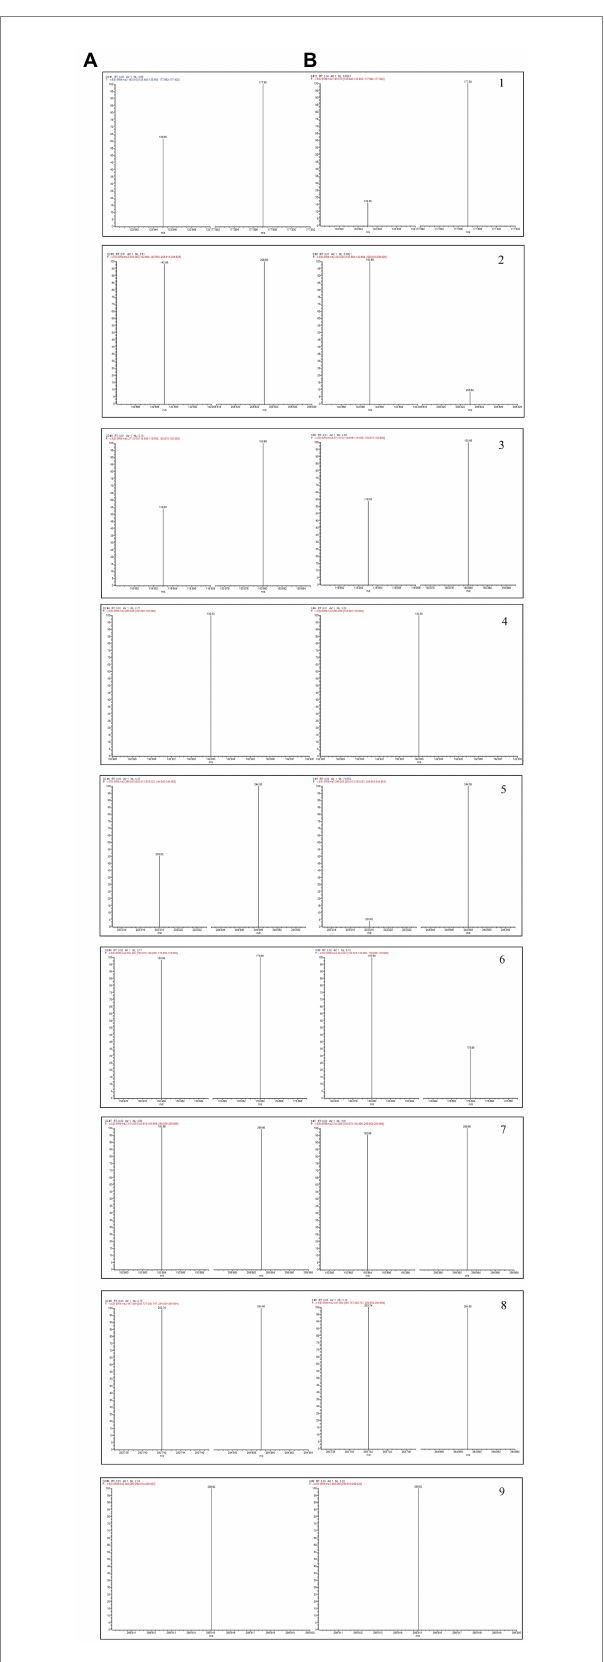
FIGURE 3 The tandem mass spectrometry (MS/MS) spectra of the standards (A) and the phenolic components in the samples (B)